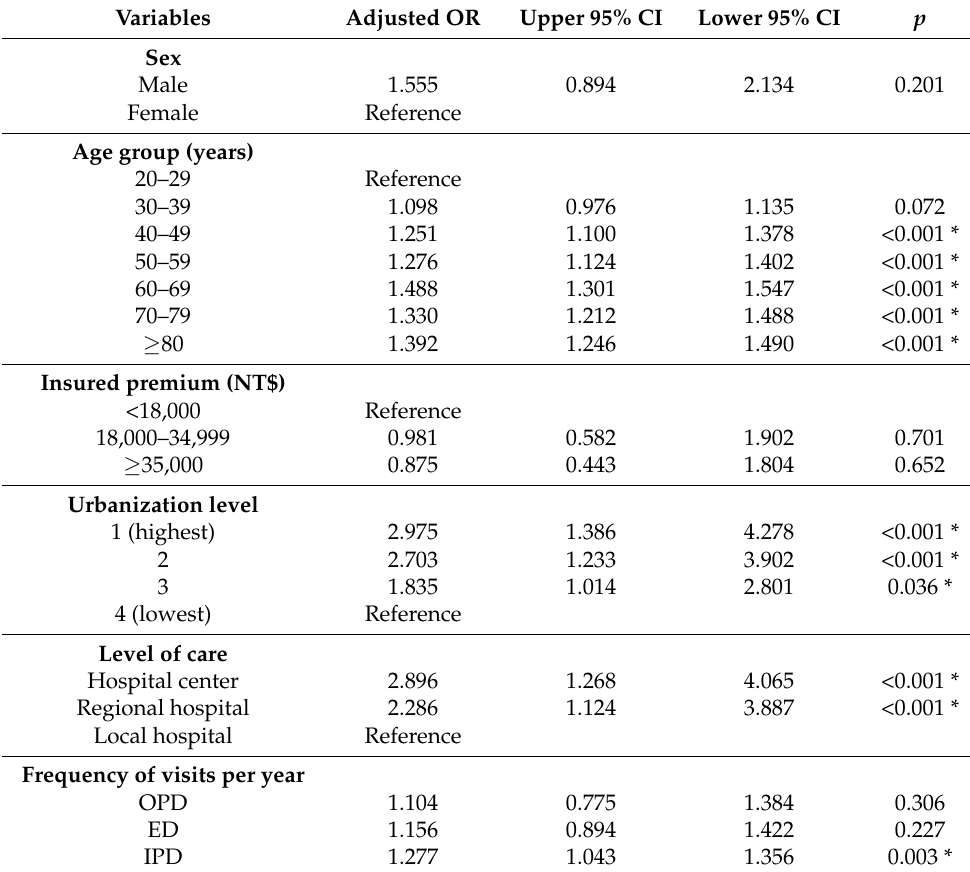
Table 5. Risk factors for cataract surgery with serious complications analyzed using multivariable conditional logistic regression among different demographic